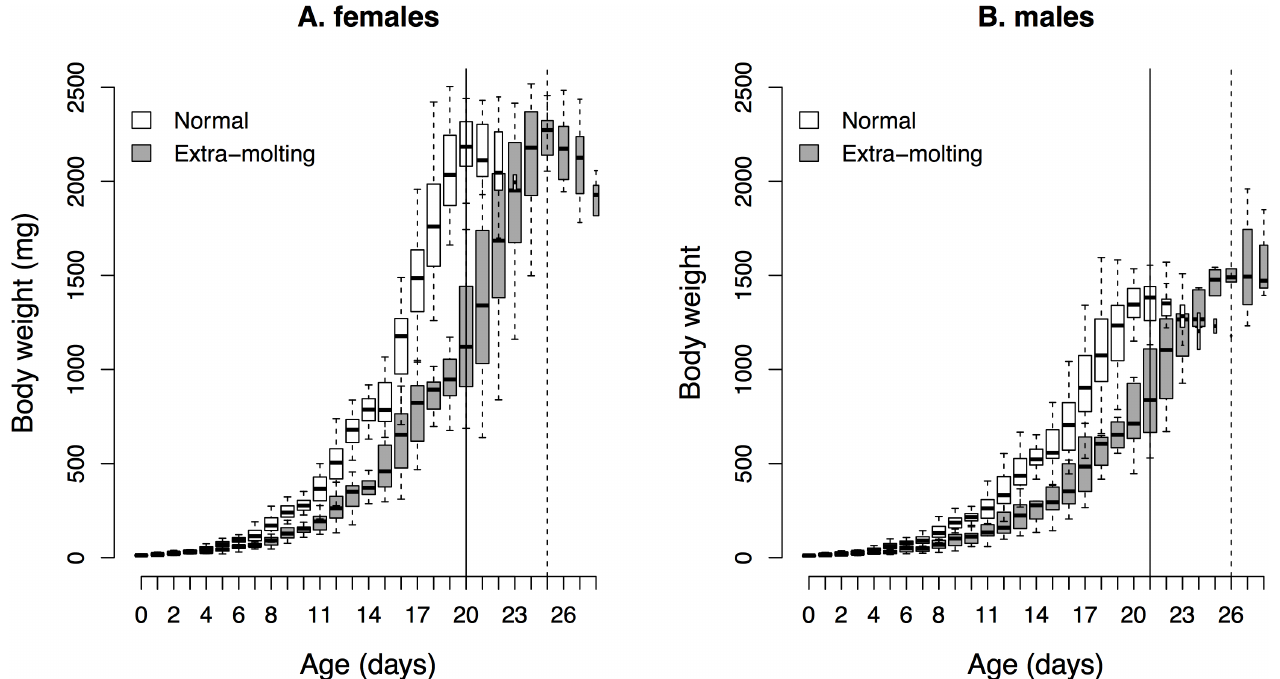
Fig 2. Nymphal growth in S . gregaria , displayed as body weight against age. A: for females only, B: for males only. For each box, black horizontal lines represent medians and notches represent its 95% confidence interval. Box width is proportional to the number of individuals in each group. Solid and dotted vertical lines represent the ages at which the maximal nymphal weight is reached in normal and extra-molting individuals respectively.